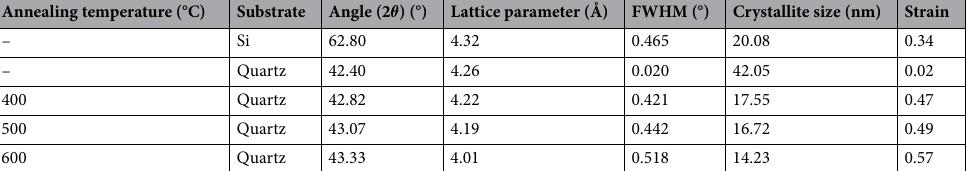
Annealing temperature